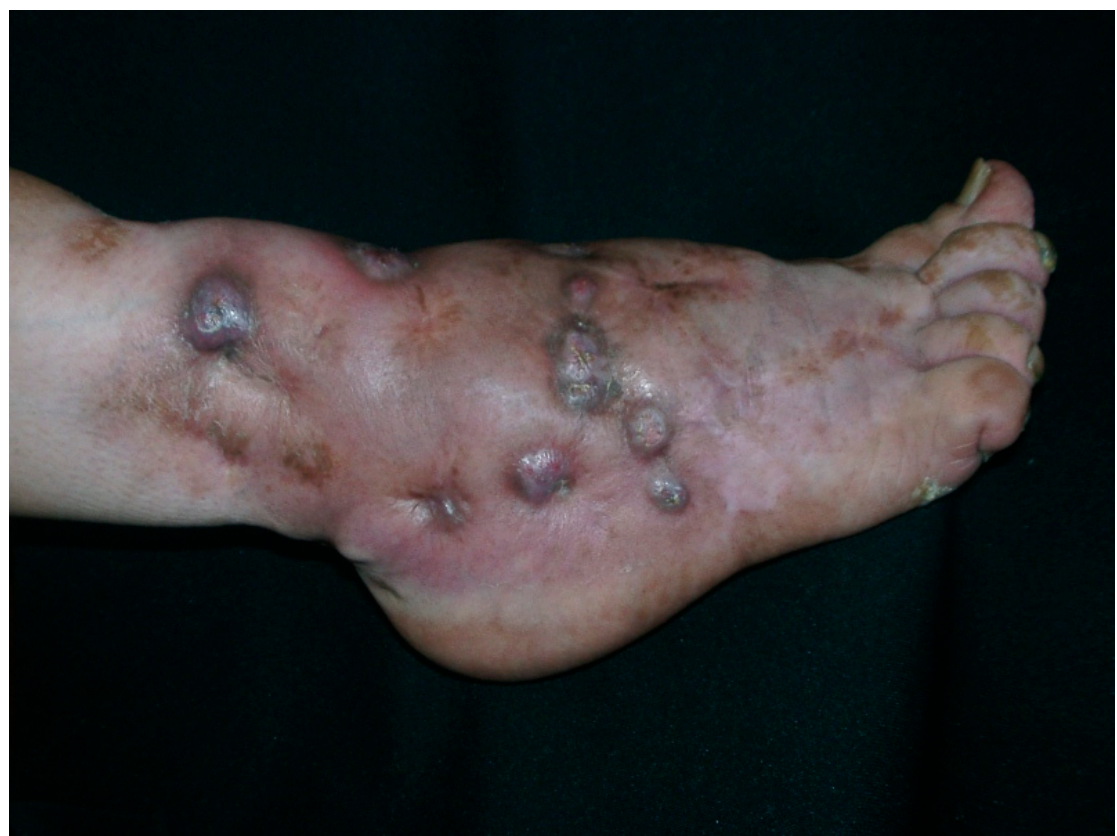
Figure 1. Eumycetoma of the foot.